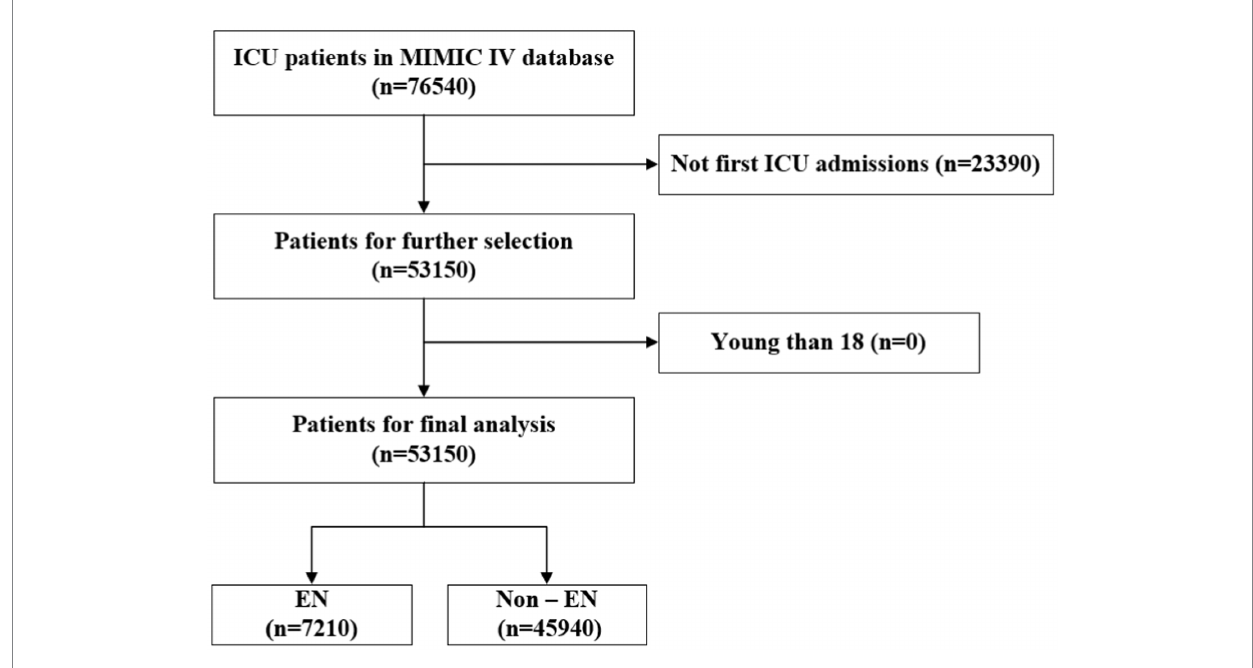
FIGURE 1 Patient selection from the MIMIC IV